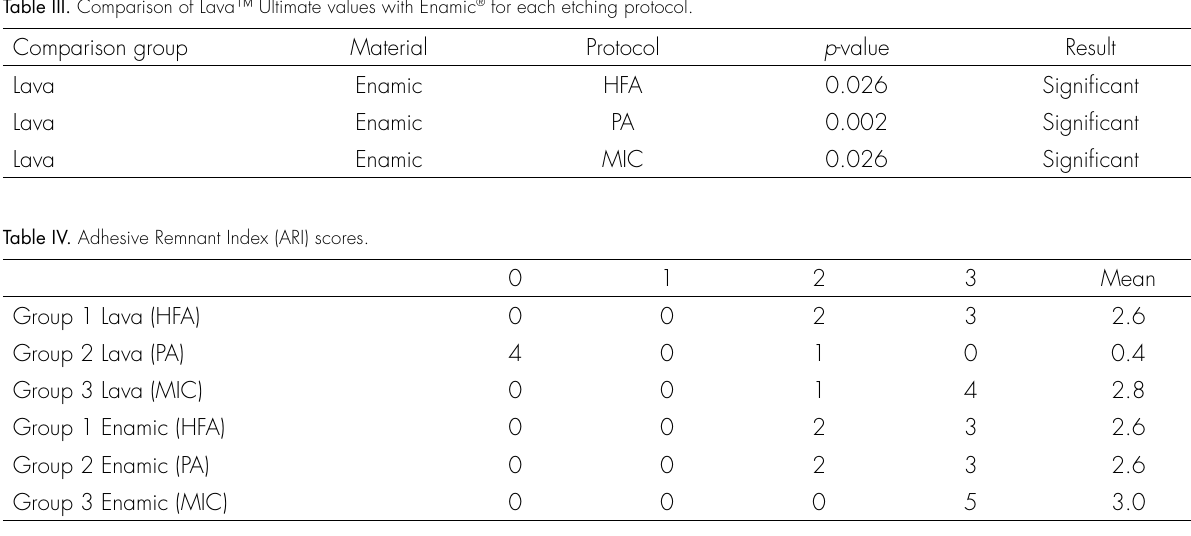
(Table IV). The Group 2 Lava ™ Ultimate (PA) mean ARI score was below 1, indicating the mode of failure occurred between the adhesive and the hybrid ceramic.